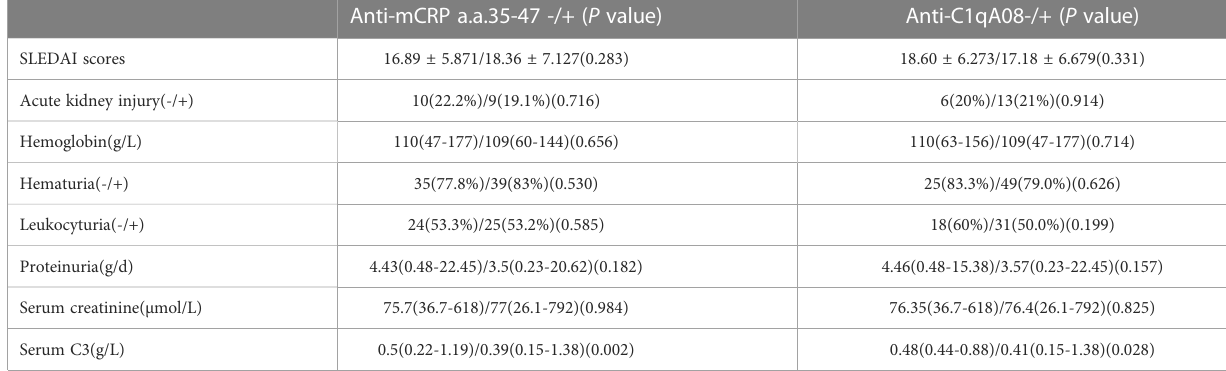
TABLE 2 Associations of anti-C1qA08 antibodies and anti-mCRP a.a.35-47 antibodies with clinical parameters.